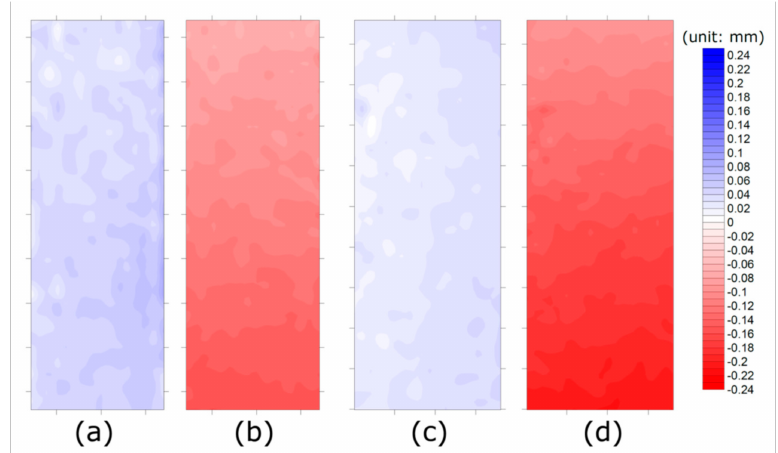
Figure 8. Displacement contours for the initial stage of stress–strain behavior (0–0.25% strain): ( a ) NC1 horizontal; ( b ) NC1 vertical; ( c ) OC1 horizontal; and ( d ) OC1 vertical.